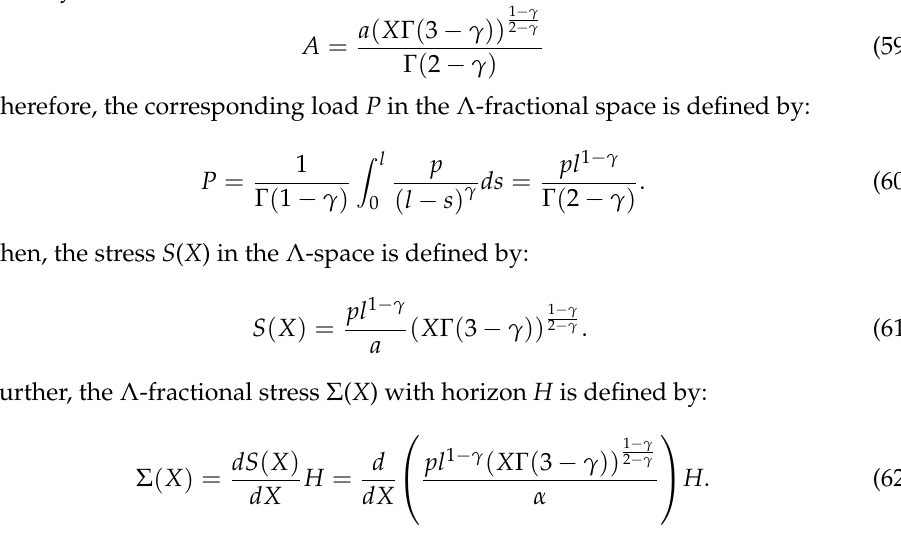
Figure 24. The diagram of the true stress in the initial space.